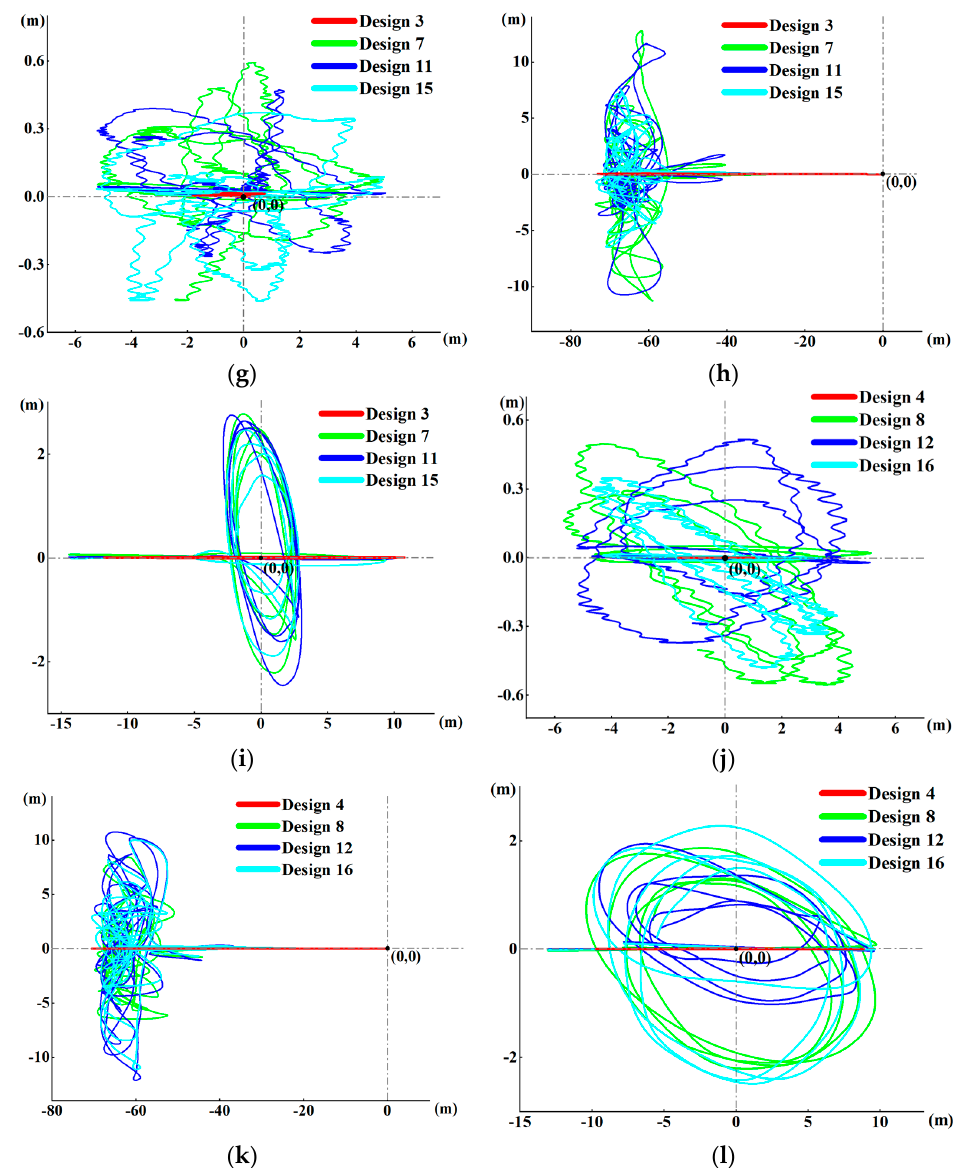
Figure 12. Motion trajectories of the platform under different positioning modes. ( a ) Motion trajec- tories diagram of the platform with different dynamic positioning modes and four mooring lines under wave load; ( b ) Motion trajectories diagram of the platform with different dynamic position- ing modes and four mooring lines under level ice; ( c ) Motion trajectories diagram of the platform with different dynamic positioning modes and four mooring lines under broken ice floes; ( d ) Motion trajectories diagram of the platform with different dynamic positioning modes and eight mooring lines under wave load; ( e ) Motion trajectories diagram of the platform with different dynamic posi- tioning modes and eight mooring lines under level ice; ( f ) Motion trajectories diagram of the plat- form with different dynamic positioning modes and eight mooring lines under broken ice floes; ( g ) Motion trajectories diagram of the platform with different dynamic positioning modes and 12 moor- ing lines under wave load; ( h ) Motion trajectories diagram of the platform with different dynamic positioning modes and 12 mooring lines under level ice; ( i ) Motion trajectories diagram of the plat- form with different dynamic positioning modes and 12 mooring lines under broken ice floes; ( j ) Motion trajectories diagram of the platform with different dynamic positioning modes and 16 moor- ing lines under wave load; ( k ) Motion trajectories diagram of the platform with different dynamic positioning modes and 16 mooring lines under level ice; ( l ) Motion trajectories diagram of the plat- form with different dynamic positioning modes and 16 mooring lines under broken ice floes.